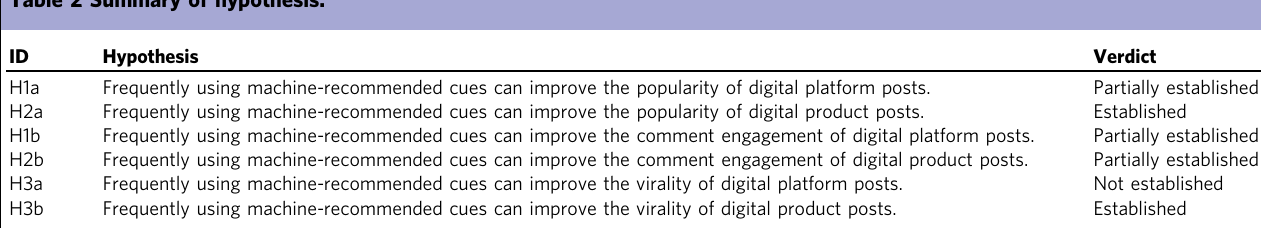
Fig. 2 Model results, in this study, all the hypotheses were validated except H3a. Table 2 Summary of